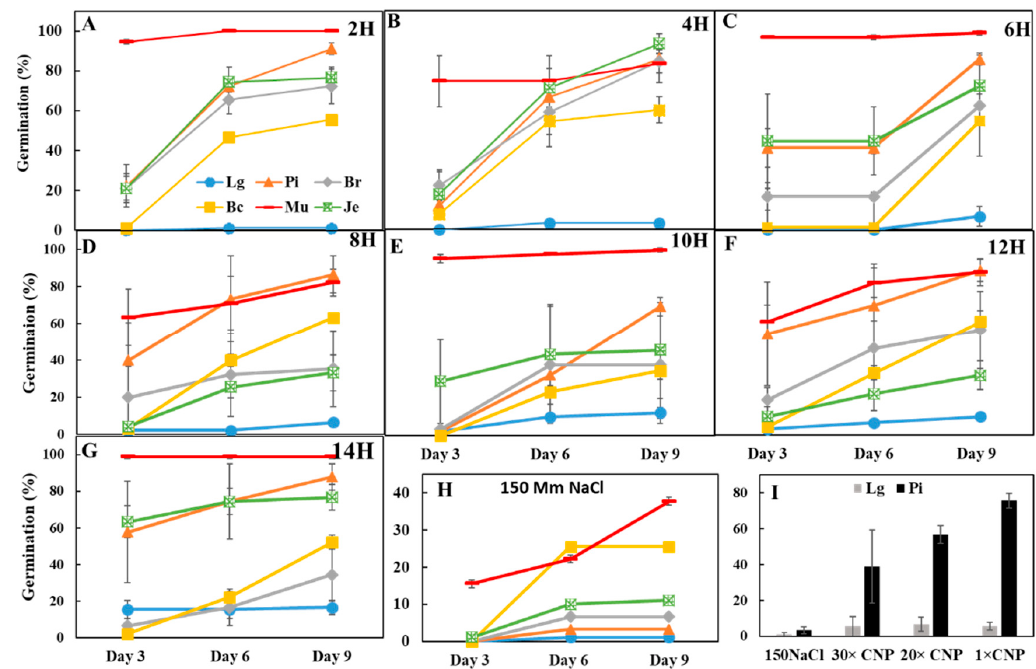
Figure 3. Germination rates of lettuce seeds pretreated for 2 ( A ), 4 ( B ), 6 ( C ), 8 ( D ), 10 ( E ), 12 ( F ), or 14 h ( G ) in 150 mM NaCl. ( H ) Germination percentages of lettuce seeds without CNP treatment in 150 mM NaCl. ( I ) Germination of Little Gem (Lg) and Parris Island (Pi) in 150 mM NaCl and 150 NaCl solution containing the original CNPs (1×) or 20× or 30× diluted CNPs.